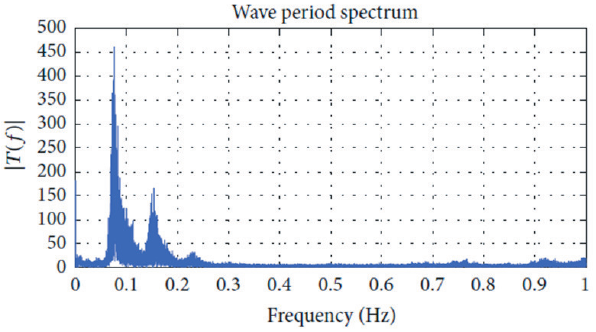
Figure 3. Representative spectral analysis of the waves at the site of Mutriku on 12 May